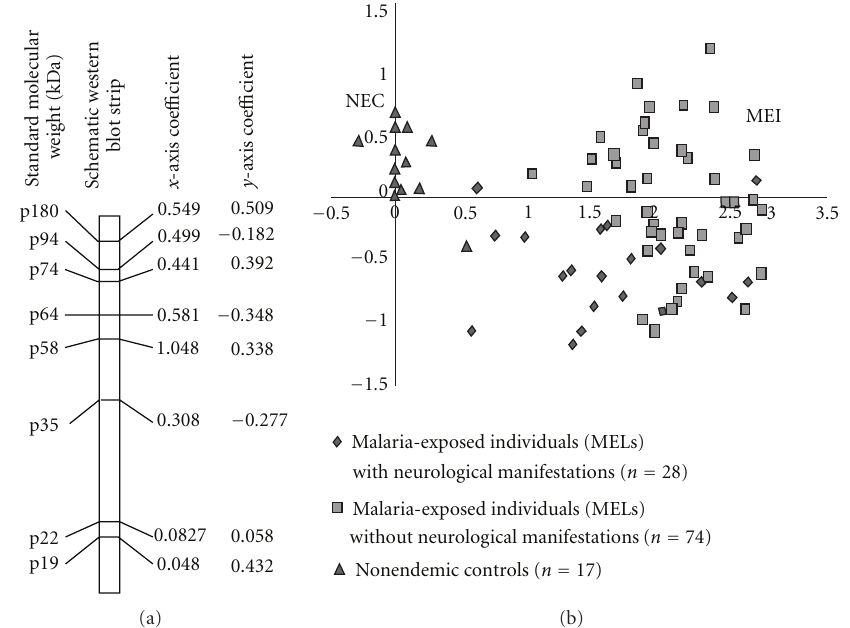
Figure 2: Identification of antigenic bands discriminating MEIs with or without neurological manifestations and NECs. (a) Schematic representation of 1 western-blot strip, showing the 8 healthy brain antigenic bands (characterized by their molecular weight) that reveal discriminatory immune reactivities with sera from MEI with or without neurological manifestations and NEC. The coe ffi cient values assigned by linear discriminant analysis (LDA; coe ffi cients for the x axis and y axis) are specified for each antigenic band. (b) Graphic extrapolation of the LDA data, obtained from the plasma tests of the 3 clinical groups of subjects revealed three distinct zones in which the NEC subjects were clearly separate from MEI.